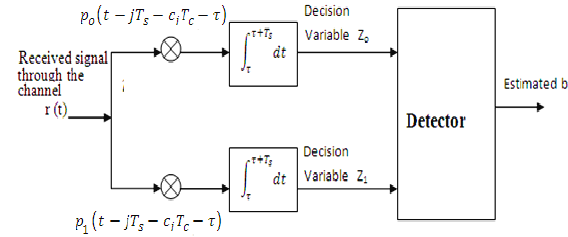
Fig.4. Receiver structure for the system model